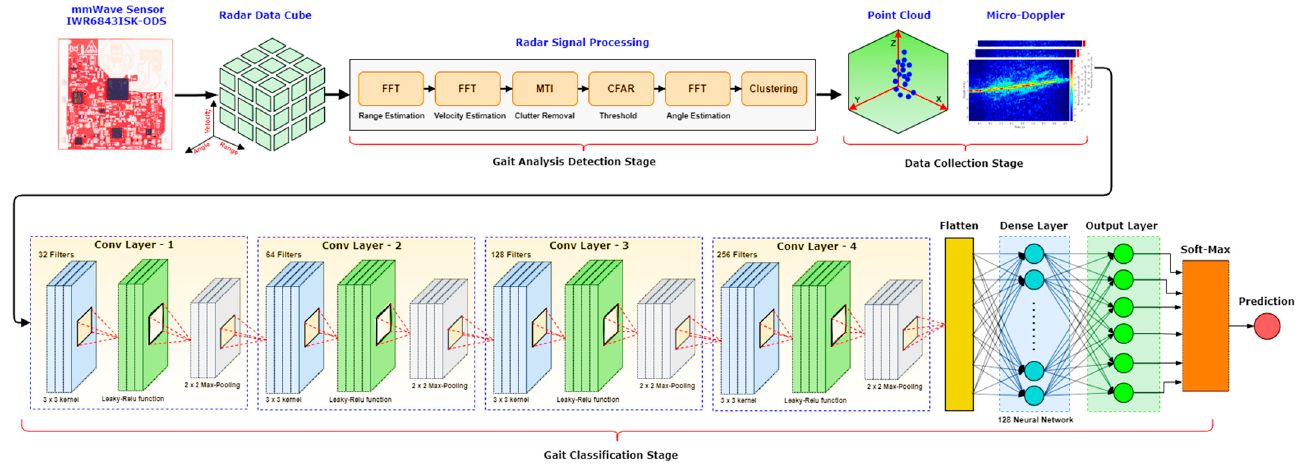
Figure 3. An overview of the proposed HAR detection method Using Micro-Doppler signatures.